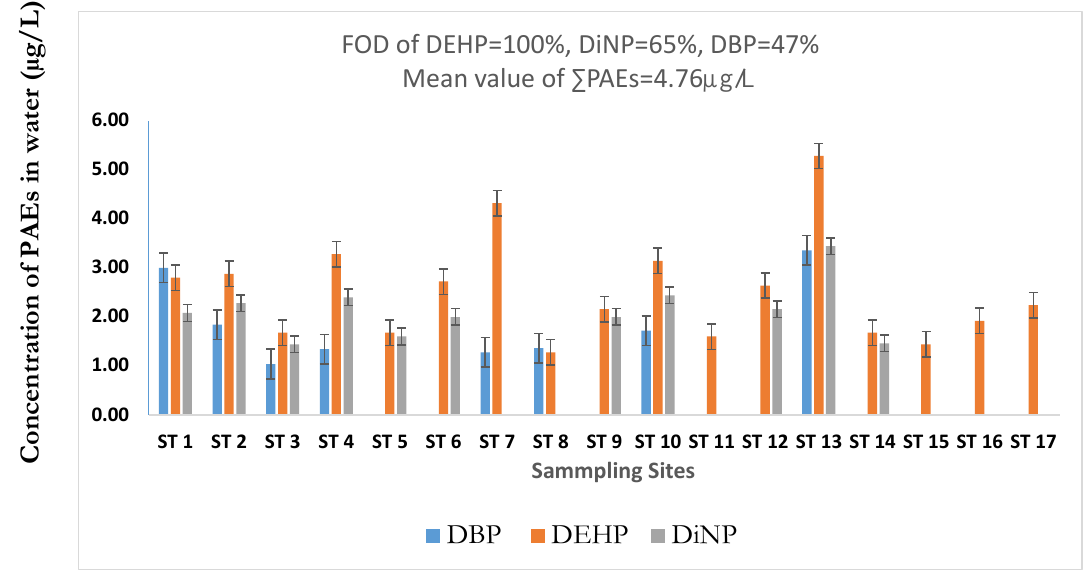
Figure 2. Distribution and Phthalate Esters (PAEs) concentrations in the Khlong U-Tapao canal. Table 1. The concentration of Phthalate esters (PAEs) in surface water of U-Tapao canal (µg/L).